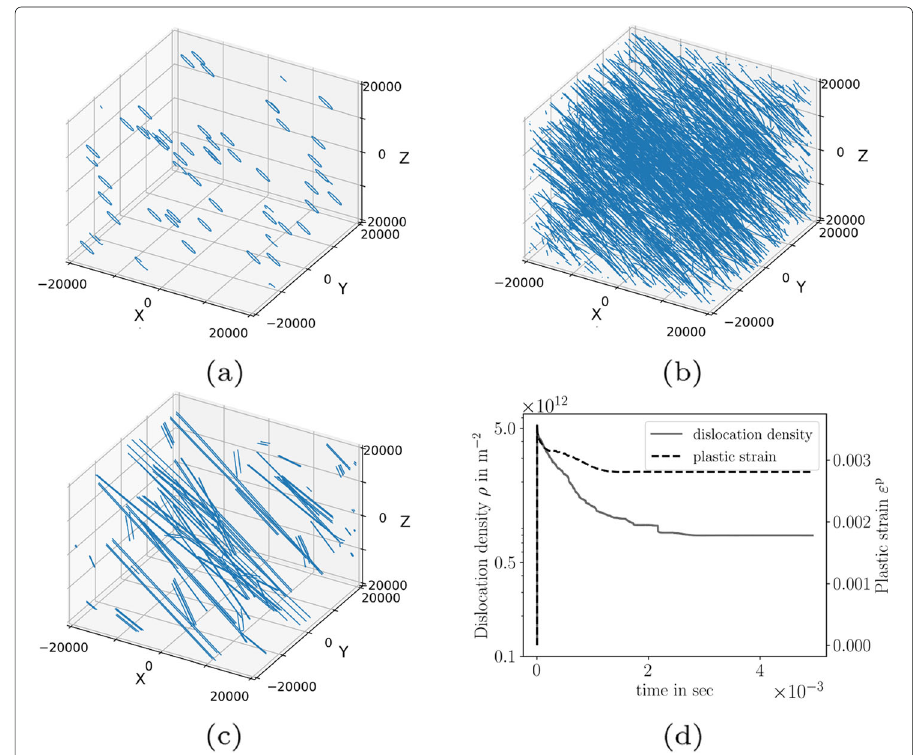
Fig. 12 Relaxation procedure for one configuration from the ensemble. The unit of the axes in ( a ) to ( c ) is the magnitude of the Burgers vector b . Initial configuration with 50 randomly distributed single slip glide loops ( a ), configuration with maximum dislocation density and external stress ( b ), relaxed configuration where dislocation activity is close to negligible with simulation time ( c ), variation of dislocation density and plastic strain with simulation time ( d